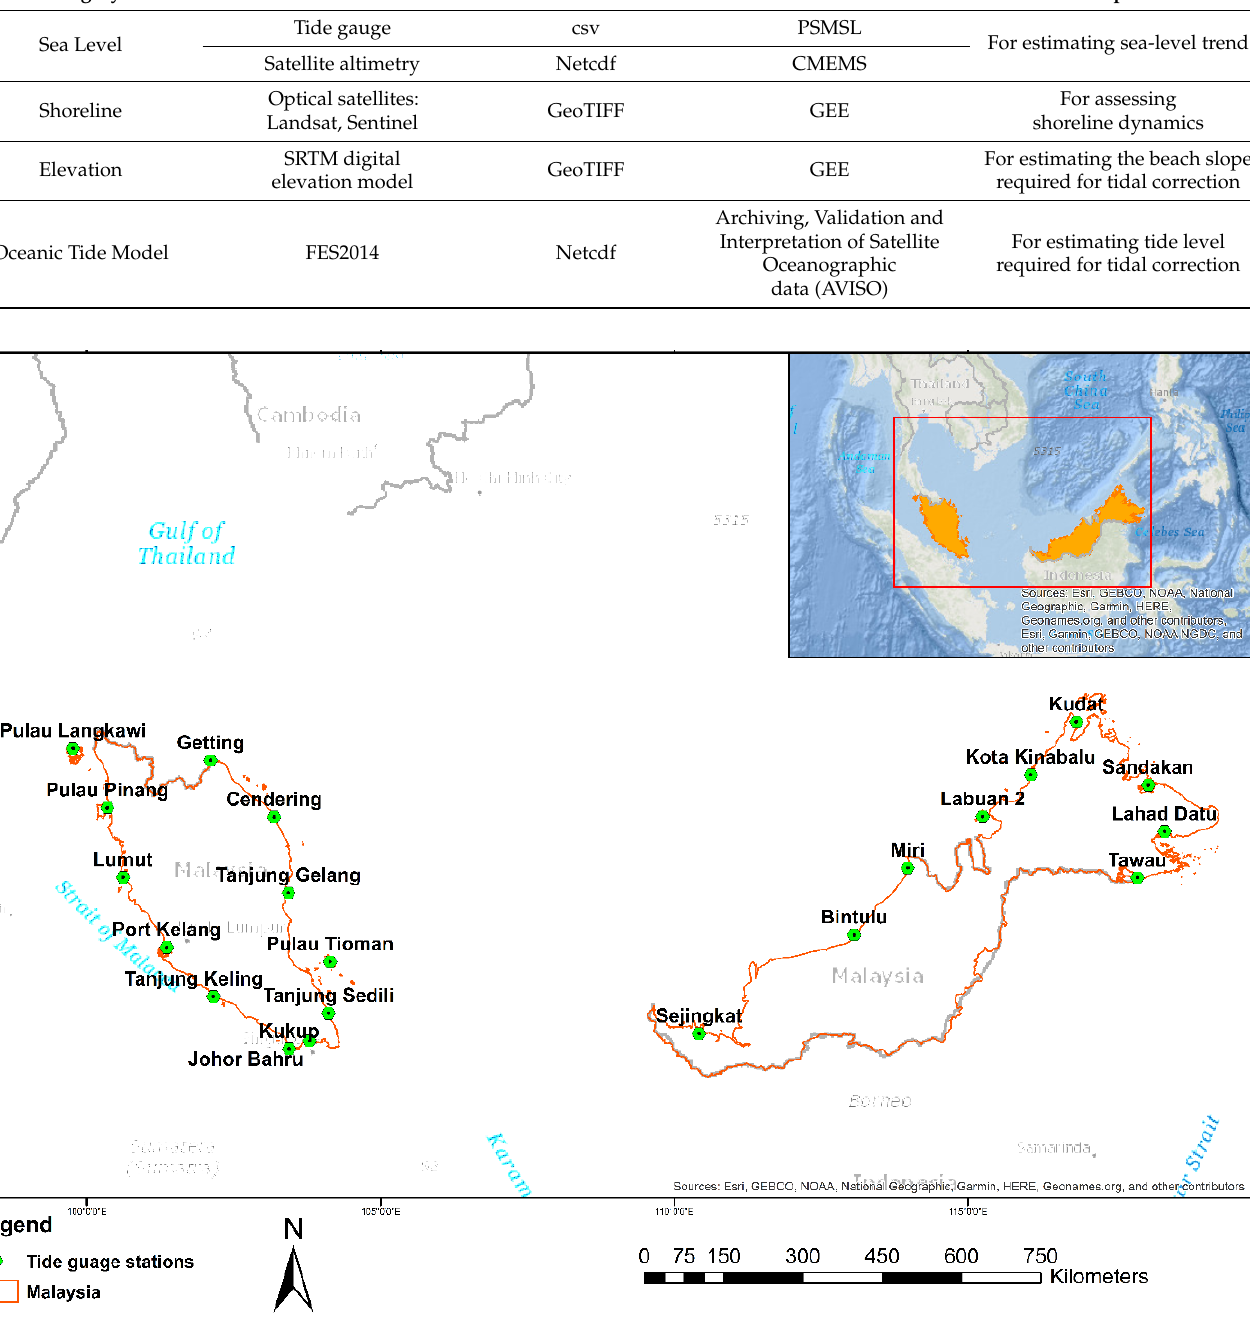
Table 1. Formats, sources, and purposes of the data employed in this study.